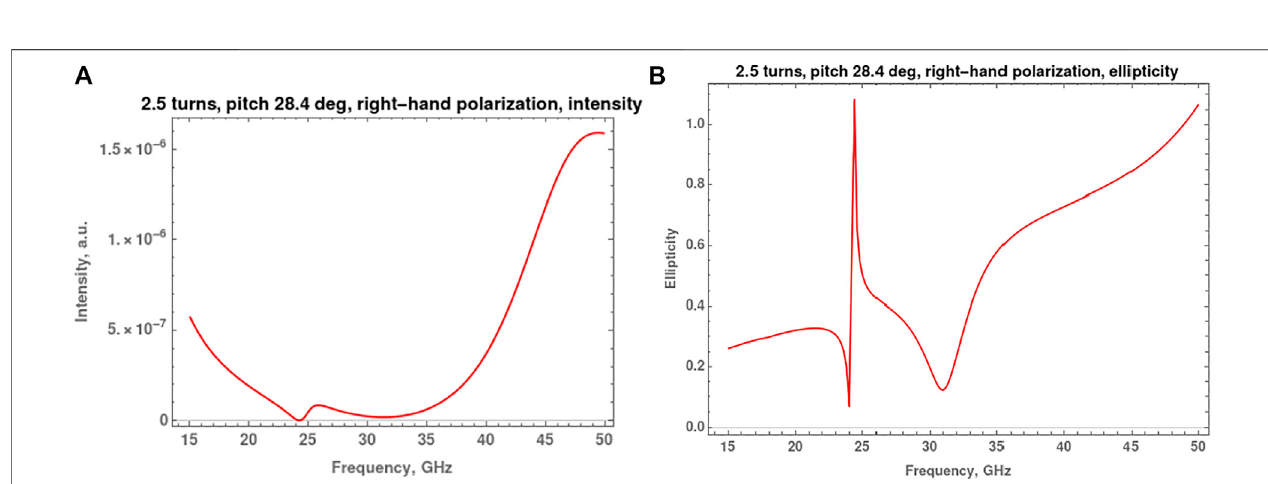
FIGURE 7 | (A) Dependence of the intensity of the re fl ected wave by single-stranded DNA-like helix on the frequency for an incident wave with right-hand circular polarization. (B) Dependence of the ellipticity of the re fl ected wave under the same conditions.